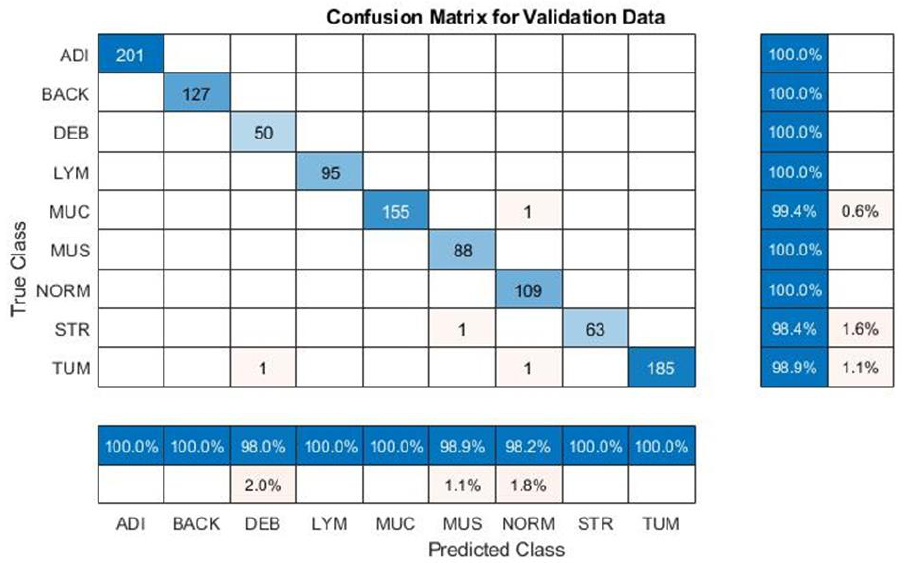
Figure 10. Experiment II: accuracy of nine classes (CRC-VAL-HE-7K).